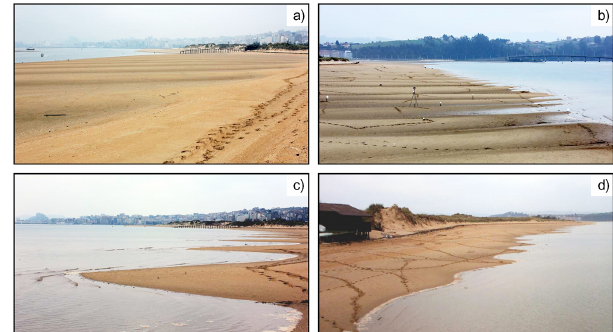
Figure 2. Photos at (a, b) low tide and with (c, d) rising tide. Pic- tures taken from the east end of the study area (a, c) , and from the west end (b, d) . Capture date: 25 February 2012.